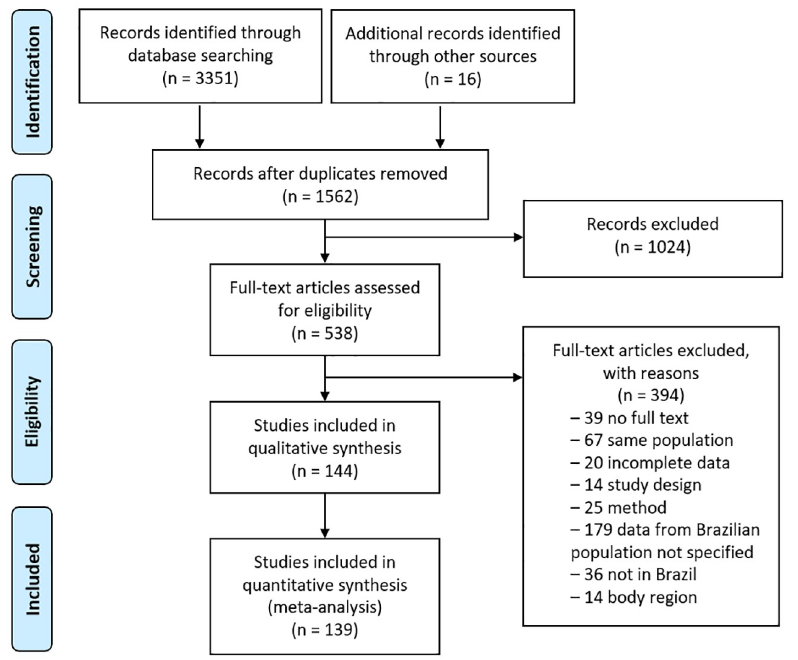
Fig 1. PRISMA flow diagram for the selection of included